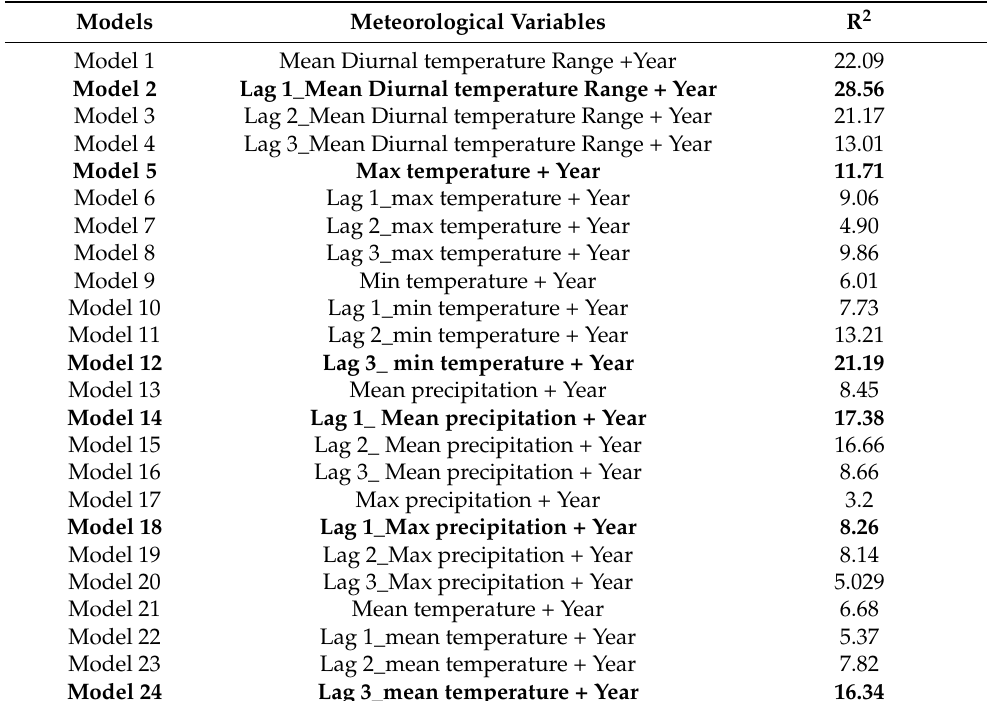
Table A2. Percentage variation explained when analysing the association of meteorological variables at different time lags on the incidence of